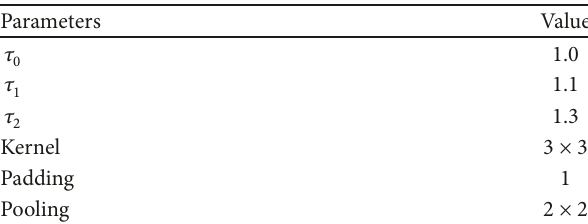
Table 1: Parameters for Line Tracer